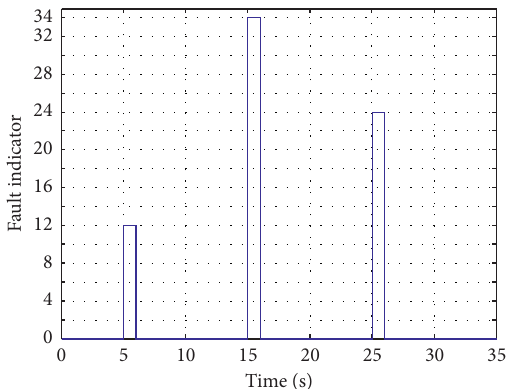
Figure 9: Fault indication output when two sensors fail simultaneously.